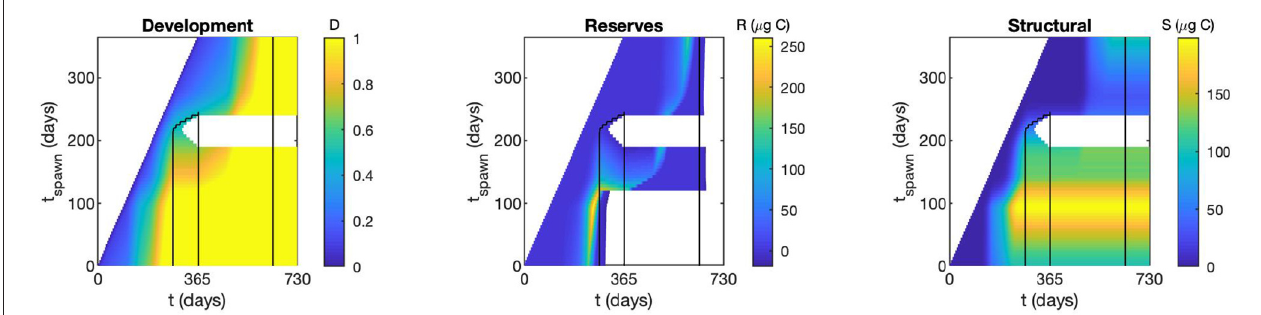
FIGURE 3 | State variables [Development (0 at egg, 1 at adult), Reserve biomass ( µ gC ), Structural biomass ( µ gC )] for a selected model run chosen to be representative of a likely scenario in Kongsfjorden. Black contours show the period within which copepods are in diapause for this example run, and white areas show non-surviving